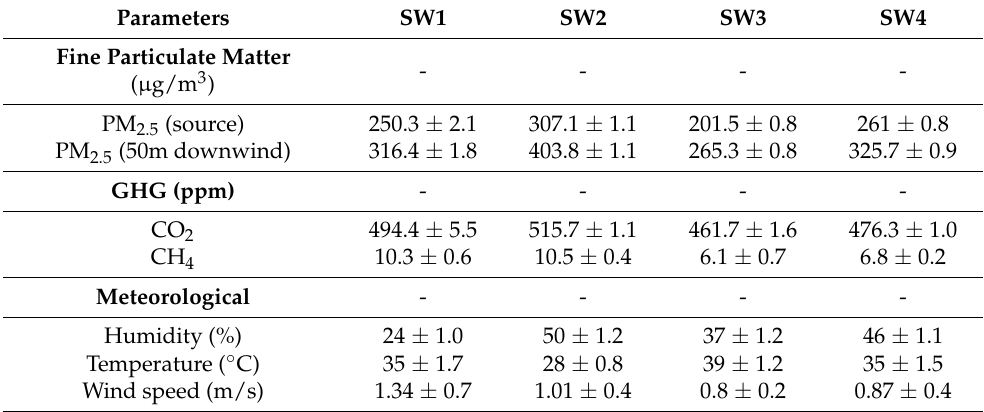
Table 2. Ambient air quality parameters at sampling sites (SW1, SW2, SW3 and SW4) during dry season along with GHG and meteorological parameters (mean ± SD, n =